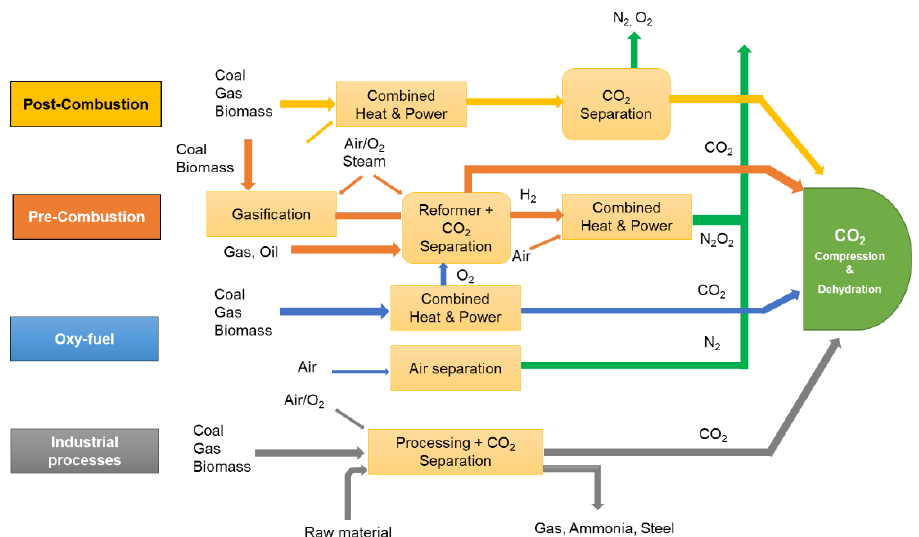
Figure 6. Graphical illustration of post-combustion, pre-combustion and oxy-fuel carbon capture technologies (Adapted from IPCC [27]).